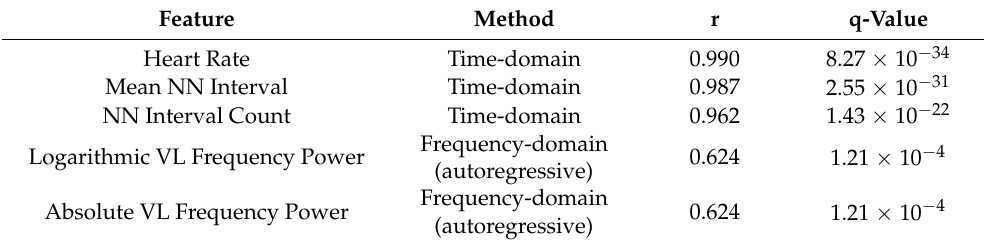
Table 5. Top five features according to the Spearman correlation test.